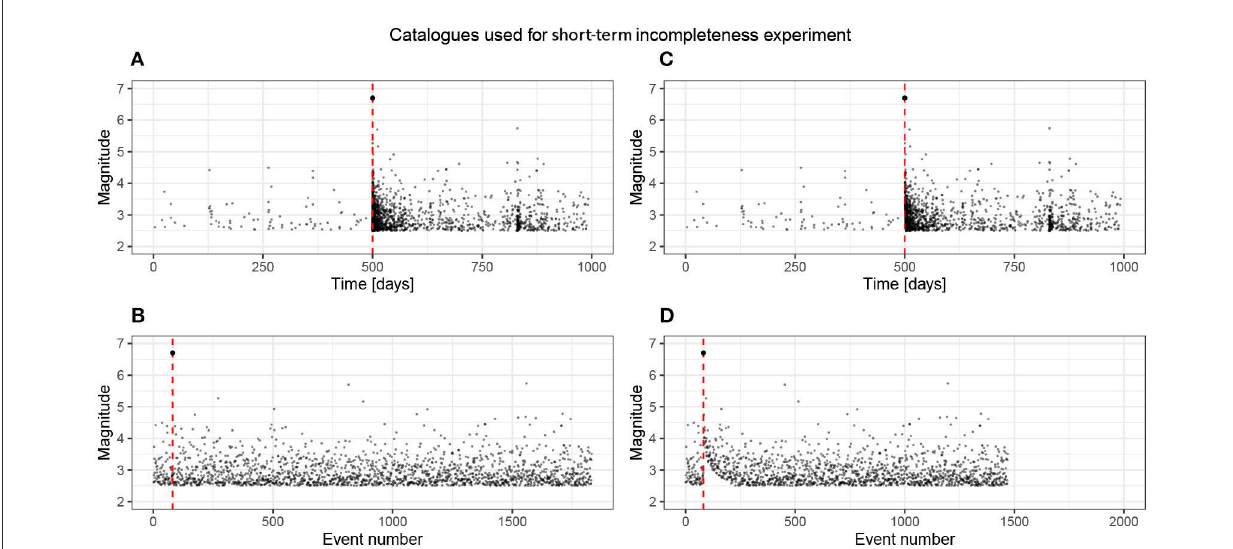
FIGURE10 Plots of the complete baseline catalog and the catalog with incompleteness artificially introduced using the functional form suggested by Helmstetter et al. [ 28]. The complete catalog contains 1,832 events, and the incomplete has 1,469 events. The time-magnitude plot does not present this incompleteness well because it occurs in the very short term after the M6.7 event. The plot of magnitude as a function of event number clearly highlights the temporally varying incompleteness just after the large event. (A) Complete catalog, nEvents = 1,832, (B) Complete, (C) Incomplete catalog, nEvents = 1,469, and (D)